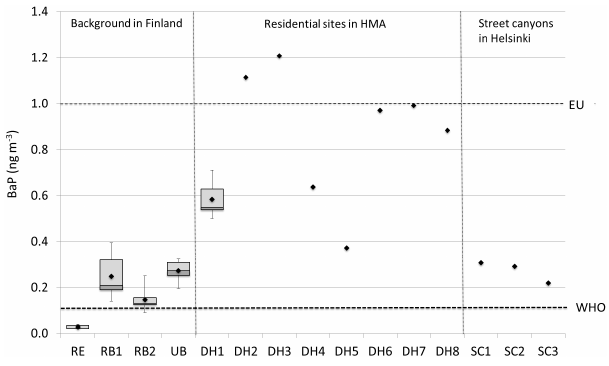
Figure 2. Measured annual means of BaP concentrations (ngm − 3 ) for different stations in Finland, a compilation of results from 2007 to 2015. The box whisker plots represent the smallest value, the 0.25 percentile, the median value, the 0.75 percentile and the largest value for each measuring site. There was only one measured an- nual mean value at the sites, for which whisker plots have not been presented. The EU target value of 1ngm − 3 and the WHO refer- ence level 0.12ngm − 3 are marked as dashed lines (HMA: Helsinki metropolitan